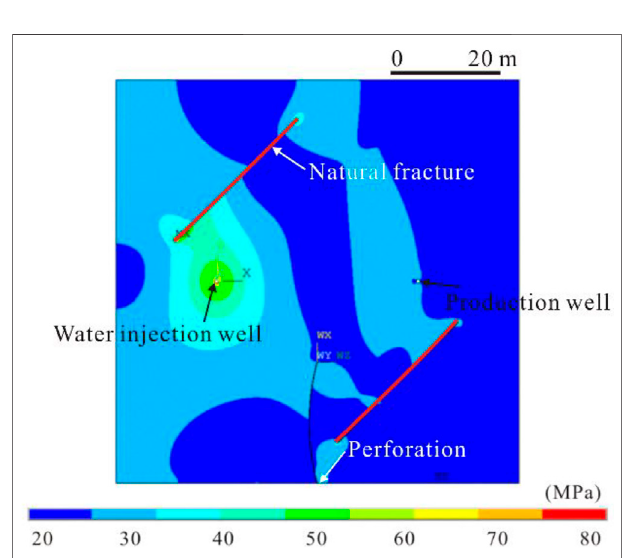
FIGURE 8 | Effect of hydraulic fracturing under the condition that the fracturing direction is oblique to the main strike of natural fractures.